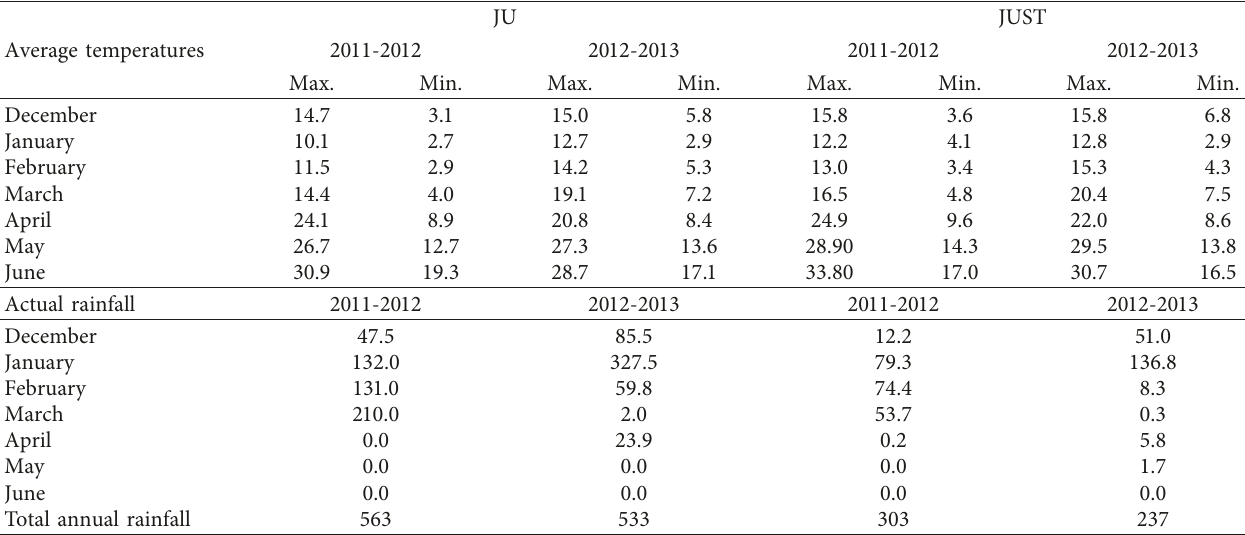
Table 2: Actual rainfall (mm on monthly basis) and average maximum (max.) and minimum (min.) temperatures ( ° C on monthly basis) in the two locations over two growing